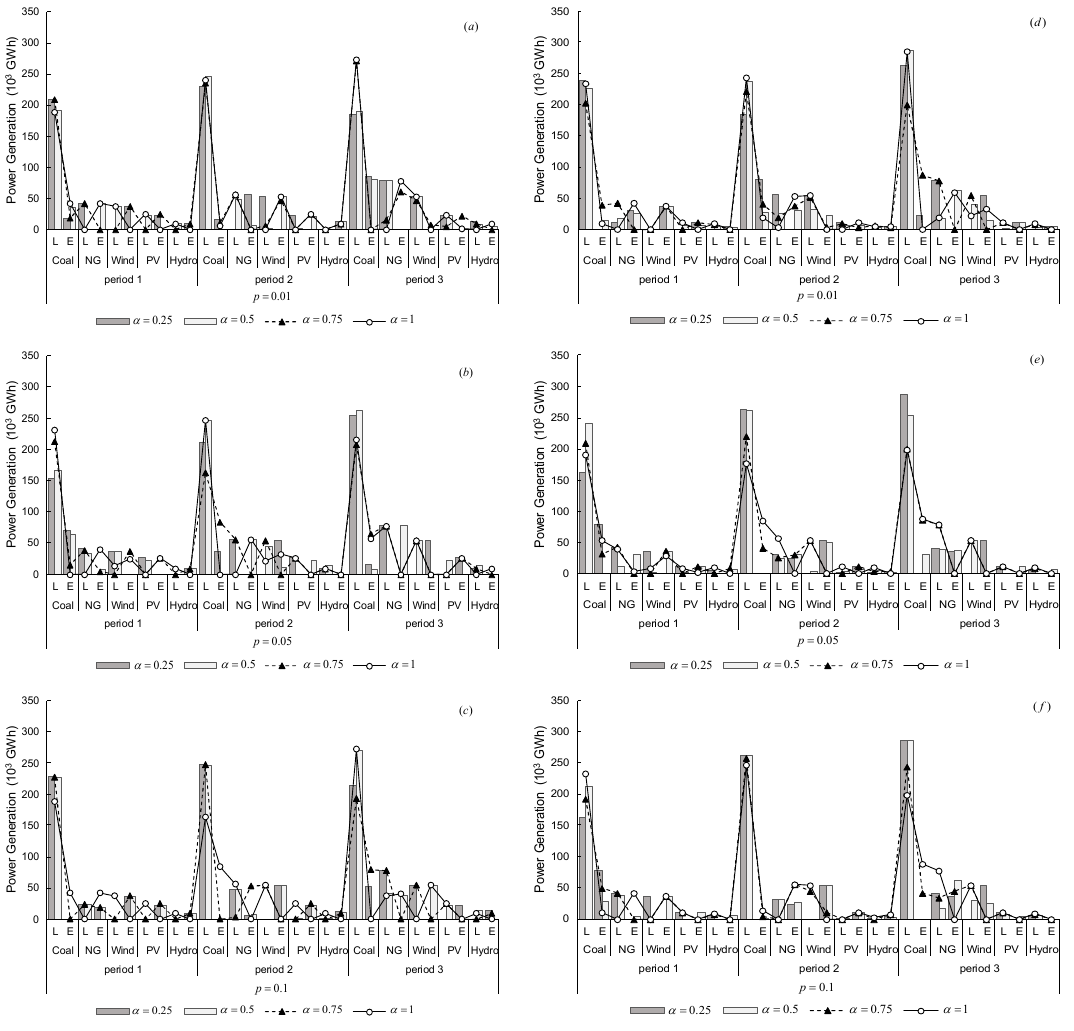
Figure 9. Power generations under di ff erent α and p levels. Note. ( a–c ): σ = 20%; ( d – f ): σ =